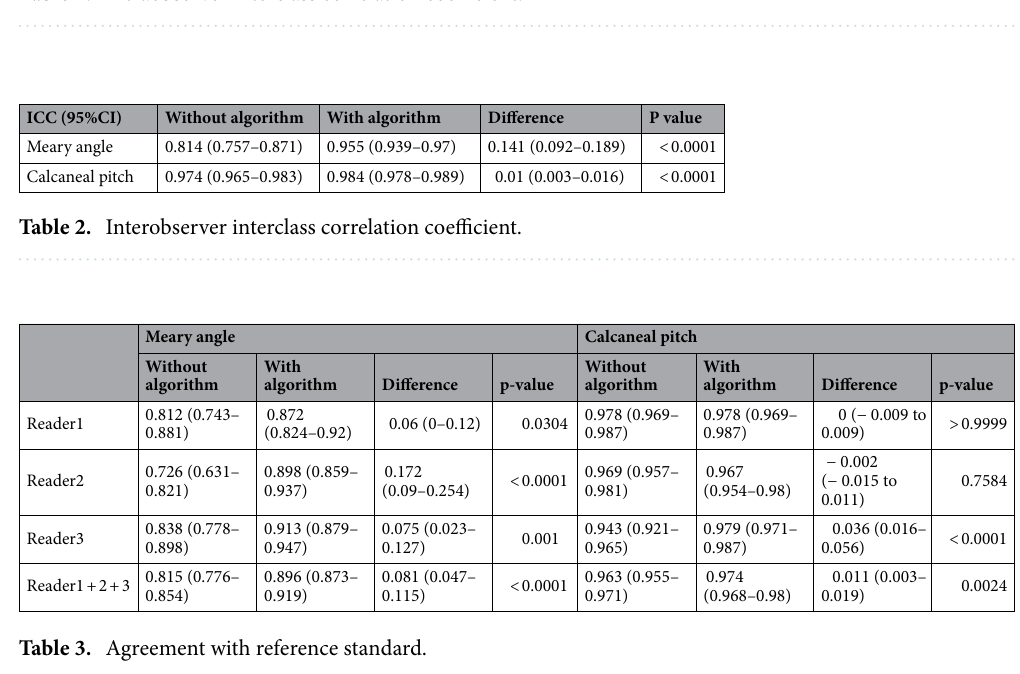
Table 1. Intraobserver interclass correlation coefficient.